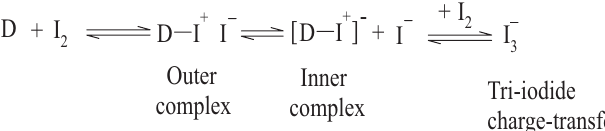
FIGURE 2 - Reaction pathway for the formation of CT complex between ALB and I in dichloromethane. 2